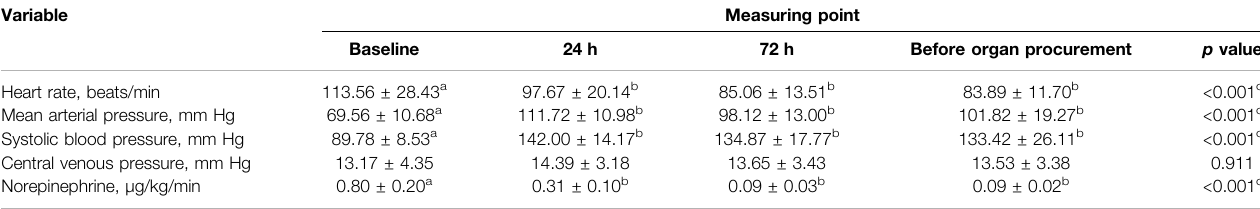
TABLE 3 | Systemic hemodynamic parameters at different points after terlipressin infusion. Variable